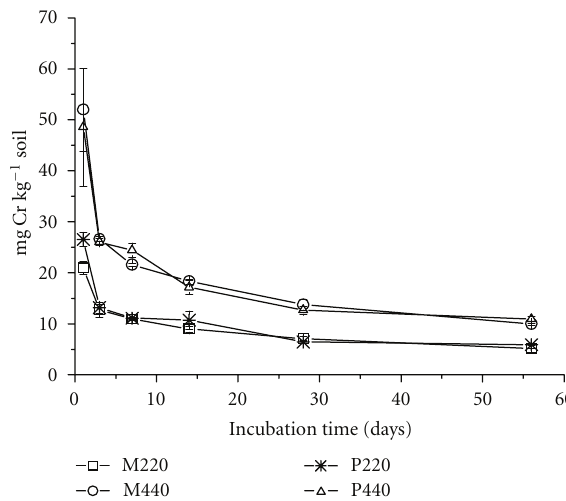
Figure 5: Dynamics of extractable Cr in soils M and P. 220: TLP addition rate at 220kg N ha − 1 ; 440: TLP addition rate at 440 kg Nha − 1 ; bars represent standard deviation ( n =